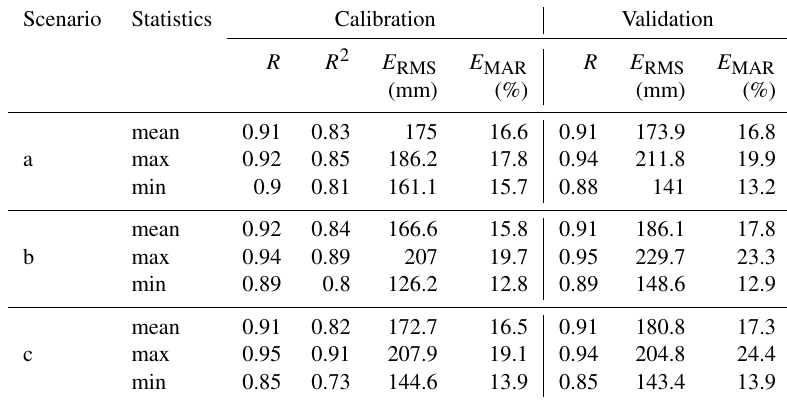
Table 2. Statistics of regression models for validation and calibration under three